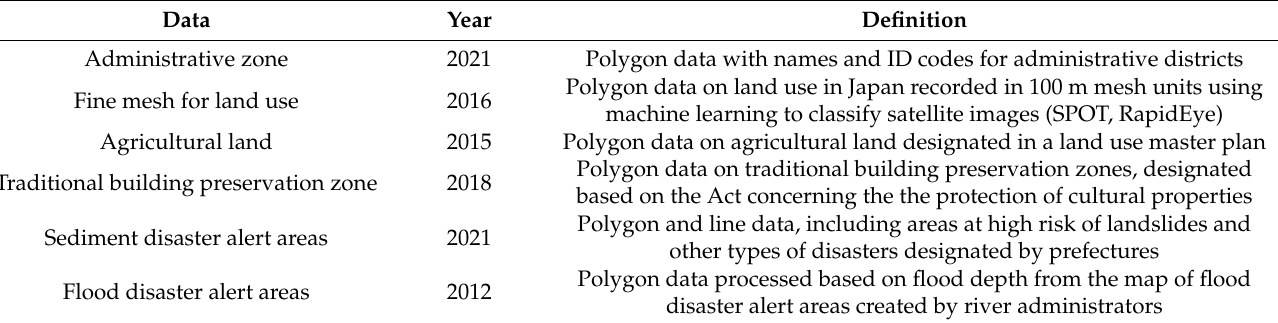
Table 4. Vector dataset used to detect abandoned farmland [26].